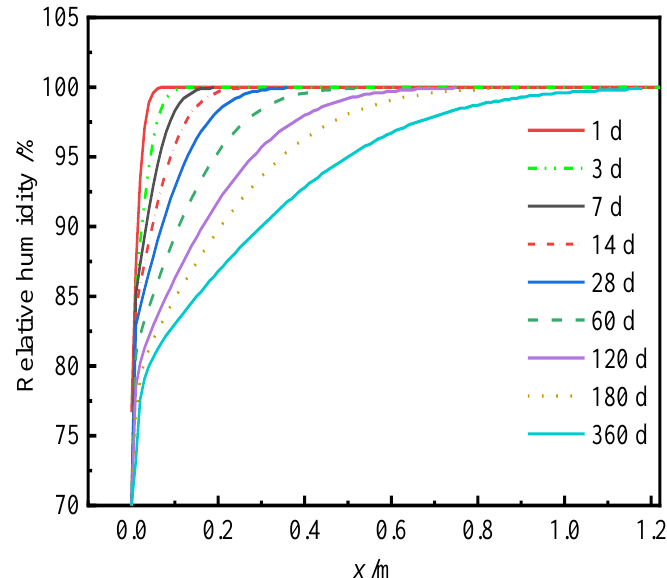
Figure 12. Relative humidity of CA mortar.